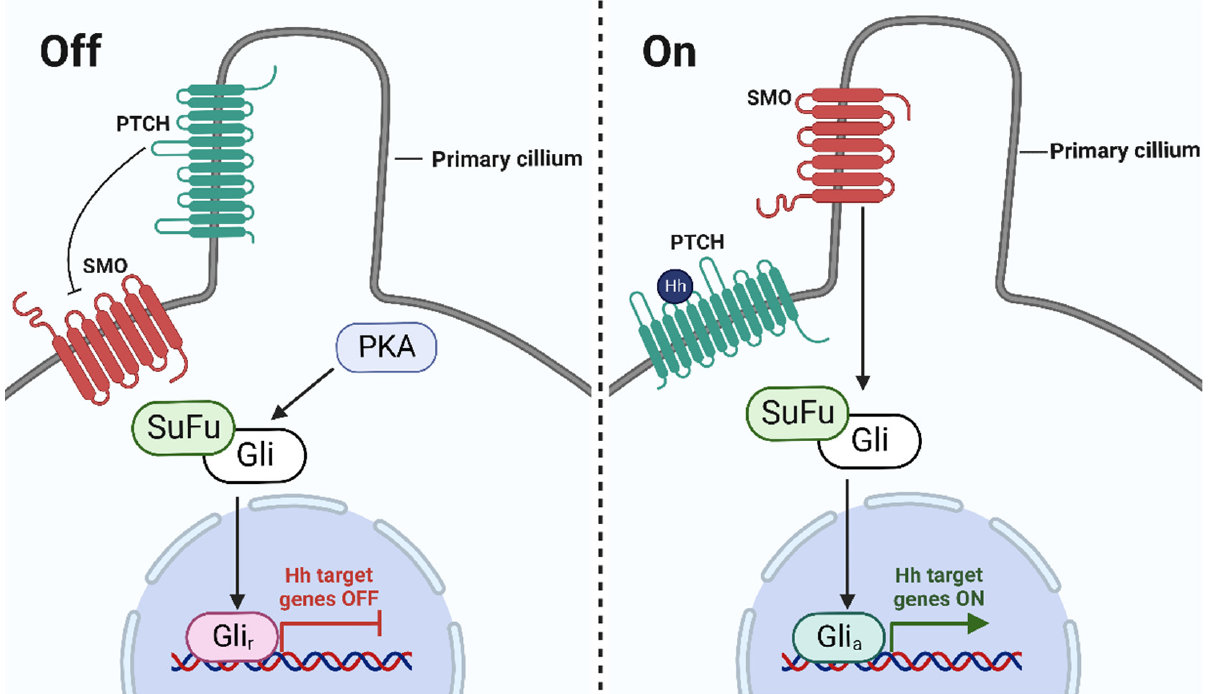
Figure 3. Schematic of the Hedgehog signaling pathway. In the absence of Hedgehog (Hh) ligands ( left ), Patched (PTCH) inhibits the G protein-coupled receptor, SMO. Protein kinase A (PKA) phos- phorylates glioma-associated (Gli) transcription factors, which then undergo proteolytic cleavage from the suppressor of fused (SuFu) to generate the repressor form (Gli r ). Gli r hinders transcription of the Hh genes and turns the pathway off. In the presence of Hh ligands ( right ), PTCH is bound by the Hh ligand, resulting in the phosphorylation of SMO. Gli transcription factors dissociate from SuFu and generate the activator form (Gli a ). Gli a promotes the transcription of the Hh genes and turns the pathway on. In the presence of a Hh pathway inhibitor such as cyclopamine, SMO will remain inactivated and PKA will phosphorylate Gli transcription factors; thus, this will generate the Gli r that inhibits transcription [46]. (Graphic created with